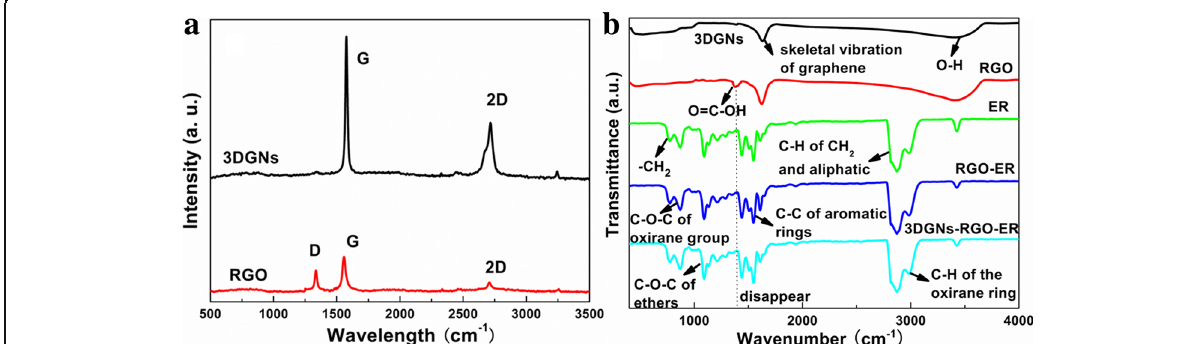
Fig. 2 Raman and FTIR curves of the various samples. Raman curves of the adopted RGO nanosheets and 3DGNs are shown in a . Three major signals, G, 2D, and D peaks, can be seen for the former, while the D peak is difficult to find in the corresponding pattern of the 3DGNs. As for the graphite-like materials, the D peak is aroused from defects. Therefore, the obtained Raman profile implies the high quality of the 3DGNs. The G band associates with the E 2g phonon at Brillouin zone center. Moreover, the defect density and average size of the RGO nanosheets can be calculated by the integrated intensity ratio of I G / I D . After calculation, the average size is ~500 nm, which is in line with the result of the SEM image. The enlarged FTIR is a useful tool to observe the chemical bond between various materials according to the intensities and positions of the corresponding signals. The major adsorption peaks and the corresponding functional groups of the ER are marked in b , and the spectra of the RGO nanosheets and 3DGNs are also presented. The similar signals at ~1600 cm − 1 and 3000 – 3700 cm − 1 are induced from the skeletal vibration of the graphene basal plane and the O – H stretching vibration of adsorbed water. A remarkable difference between these two profiles is that an additional obvious peak at 1335 cm − 1 arising from the O=C – OH can be seen only for the RGO nanosheets resulting from the surface functional groups. After combining with the ER, the O=C – OH signal disappears absolutely, manifesting that the carboxyl on the surface of the RGO nanosheets reacts with hydroxyl of the ER to form a close chemical contact, which contribute to the phonon fast transport at the interface between them